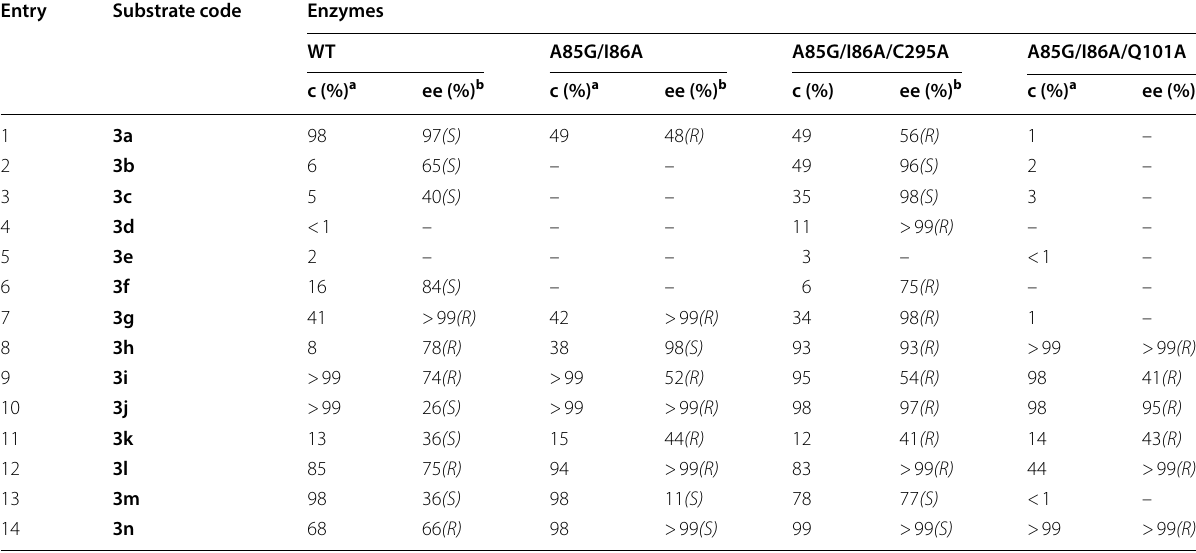
Table 5 Asymmetric transformations of ketone 3a–n by TbSADH mutants evolved for ketone 1